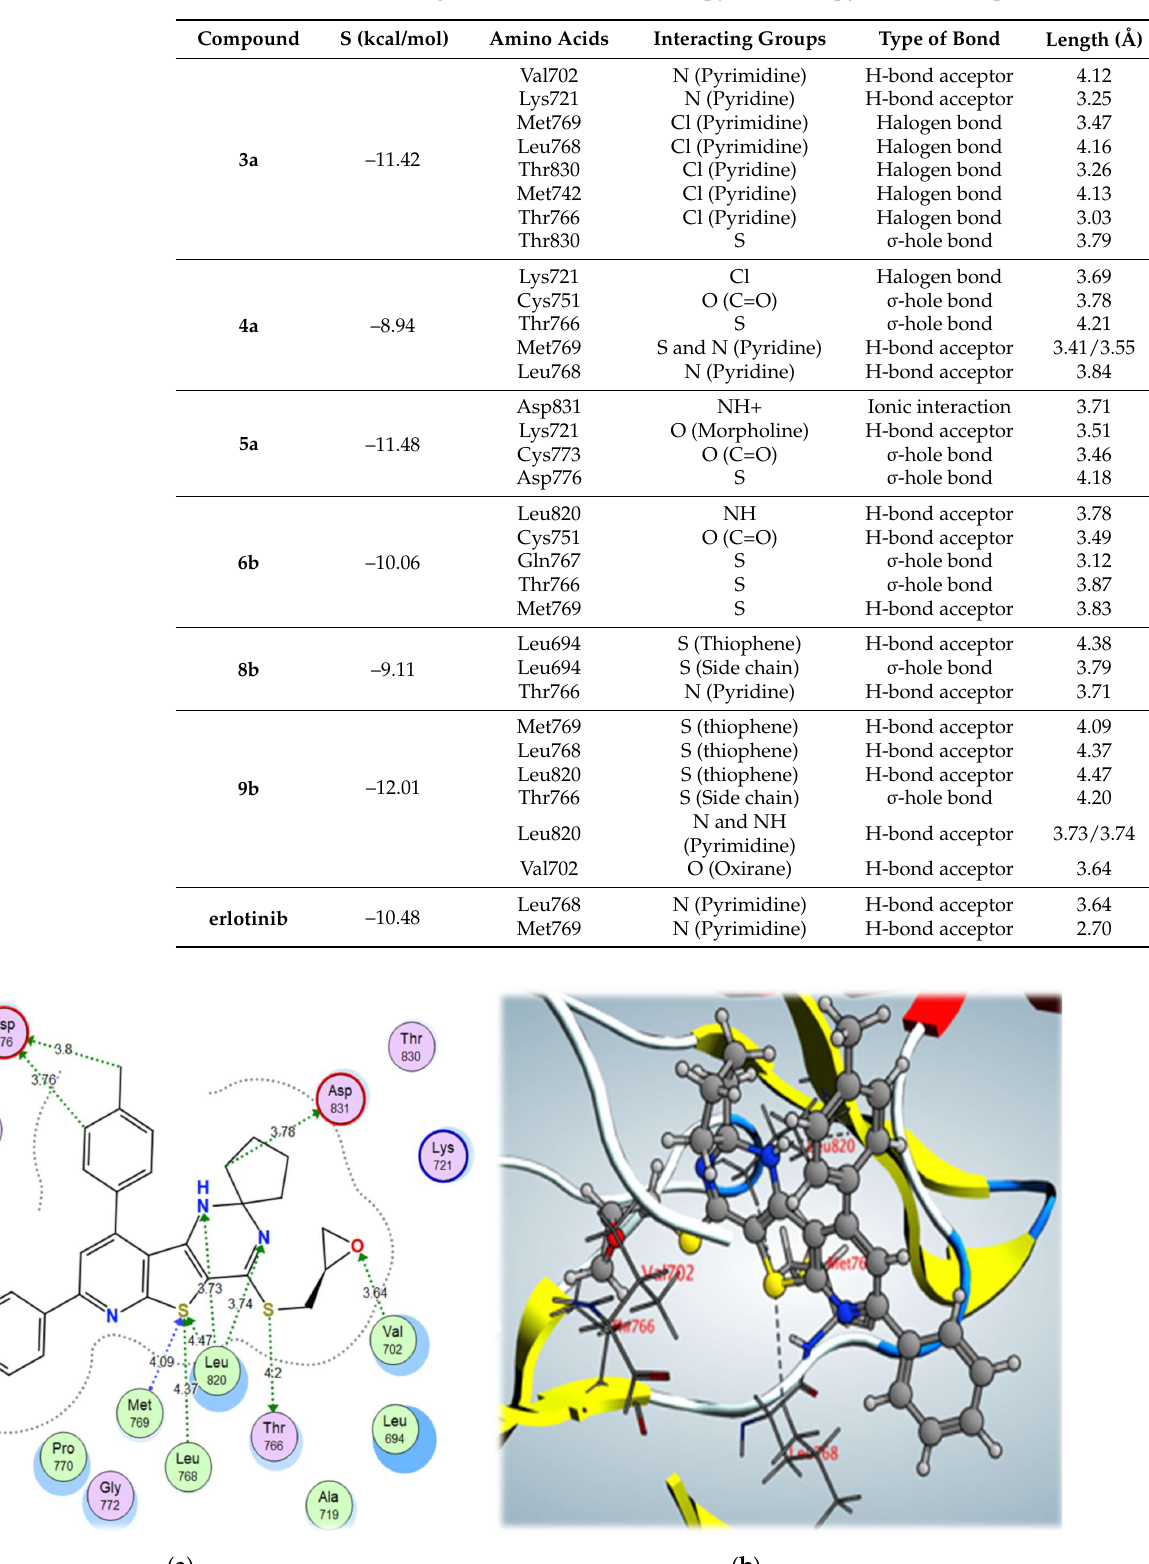
Table 5. Molecular docking results of the most active pyridothienopyrimidine compounds.